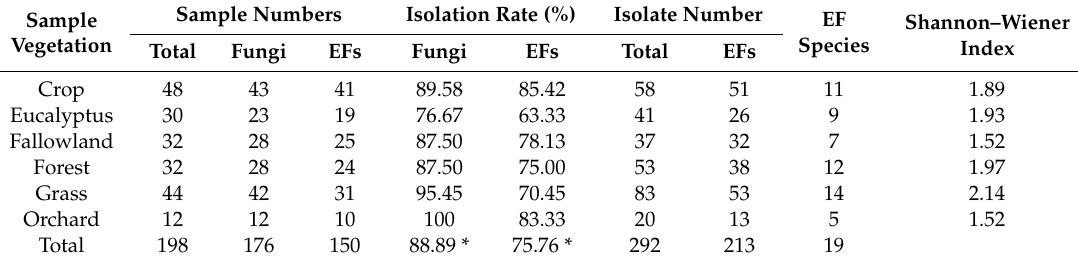
Table 3. The fungi isolation and biodiversity of di ff erent samples.